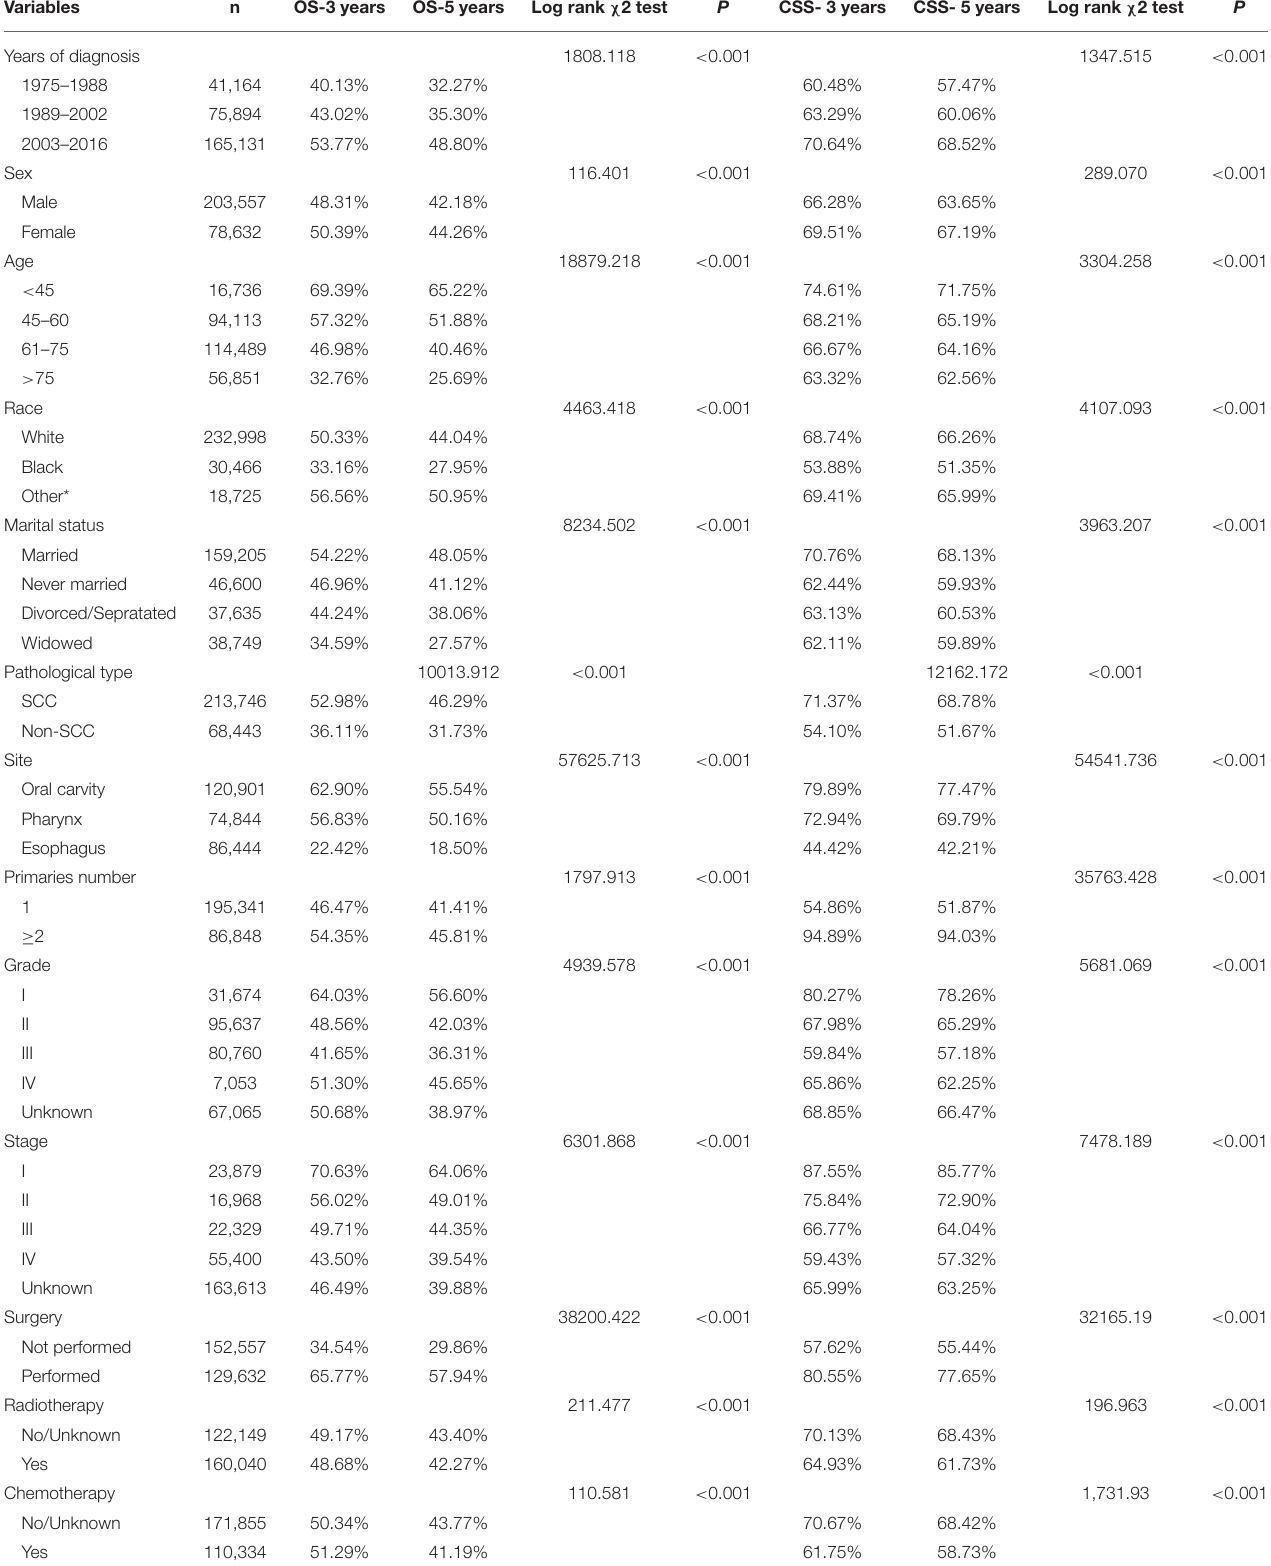
TABLE 2 | Univariate survival analyses of patients with UDTT according to various clinicopathological variables.